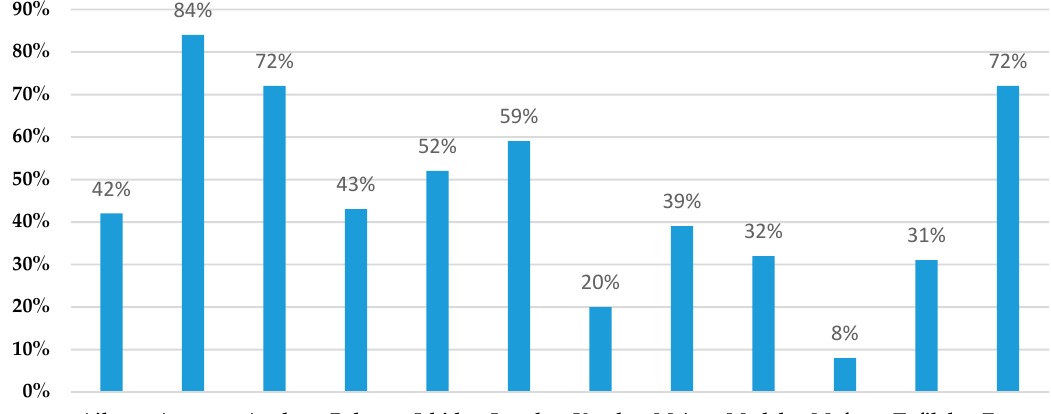
Figure 9. Percentage of population connected to sewerage network for each governorate in Jordan [15].